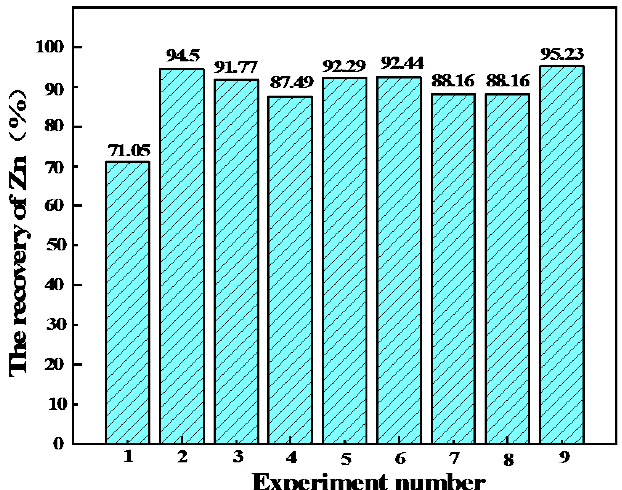
Figure 10. Recovery ratios of zinc in alkali leaching experiments under different conditions.